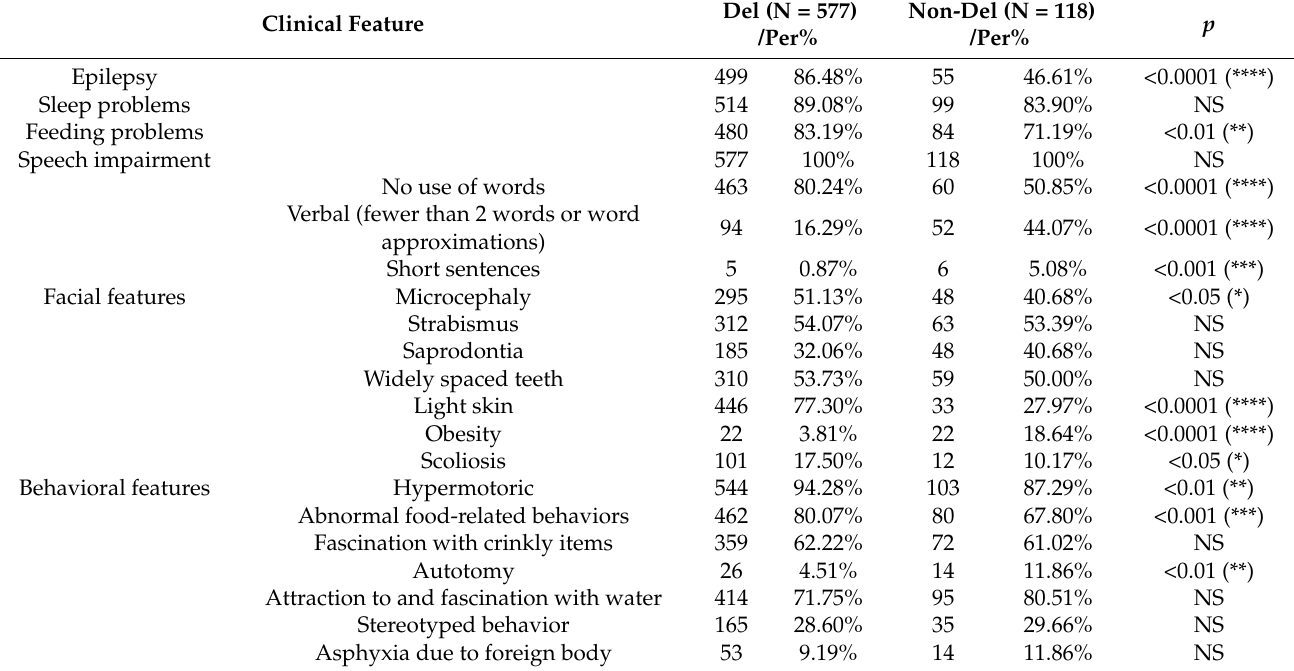
Table 2. In the deletion group, abnormal food-related behaviors were more serious, while the non-deletion groups had more autonomous behaviors. Table 2. Comparison of clinical features in AS caused by deletion versus